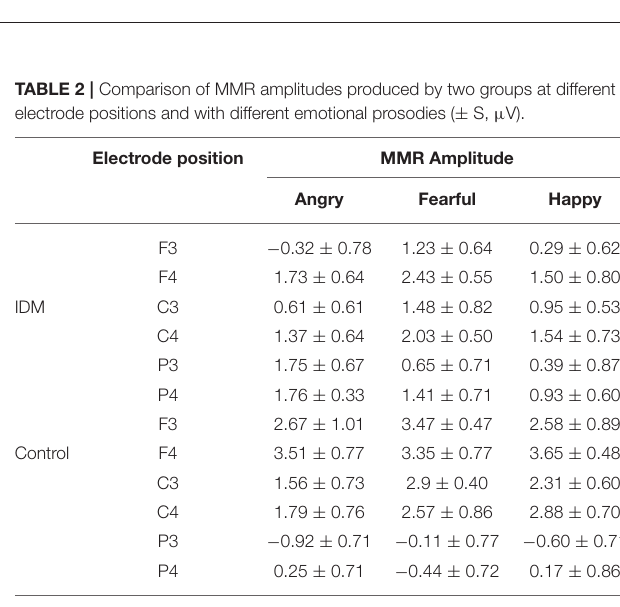
FIGURE 1 | The pattern of vocal voice broadcasting.